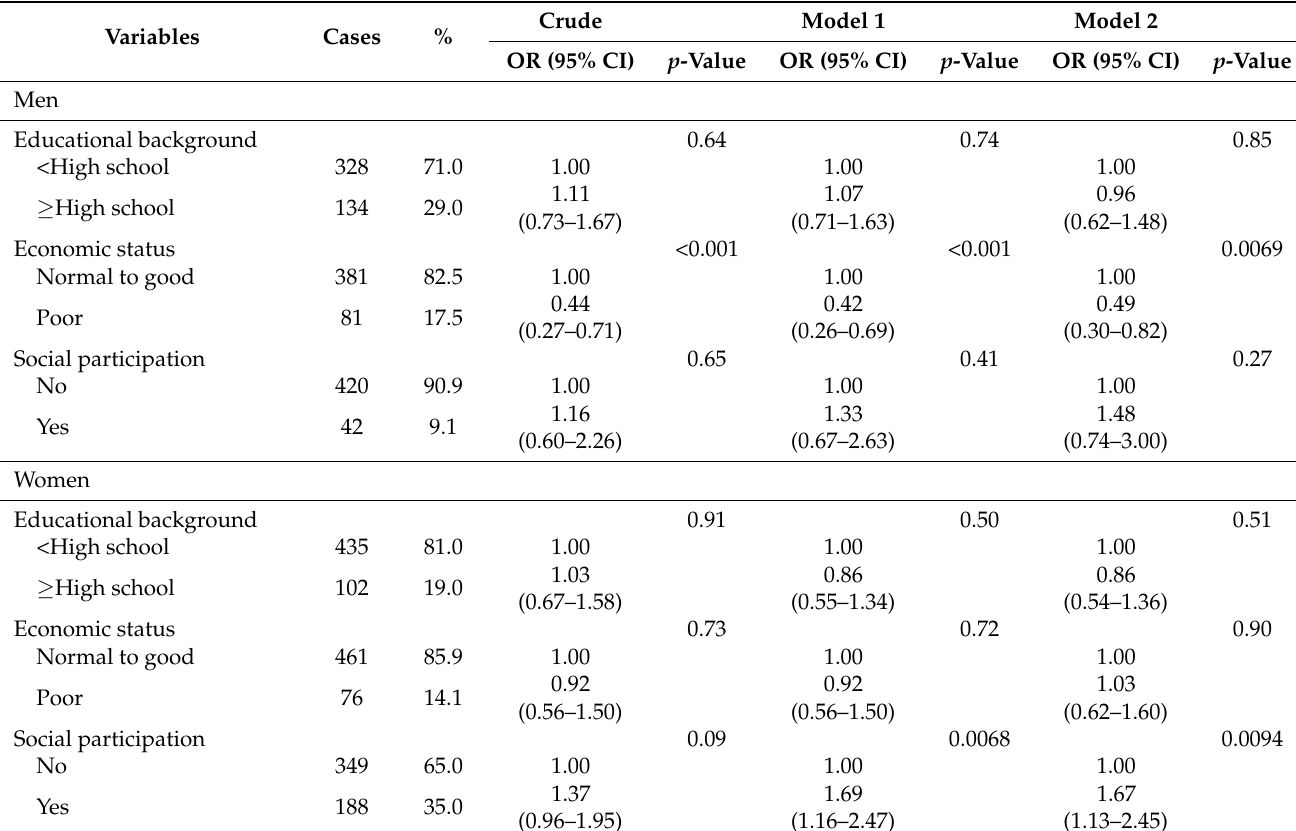
Table 3. Odds ratio of increasing or maintaining MVPA for socioeconomic status and social participation in men and